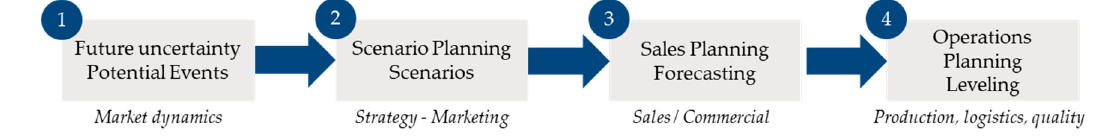
Figure 1. Managing future uncertainty (own elaboration).